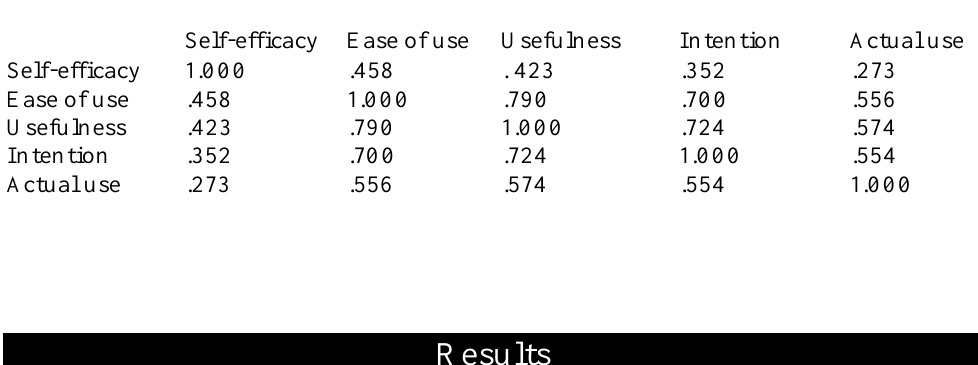
Correlation Matrix Self-efficacy Ease of use